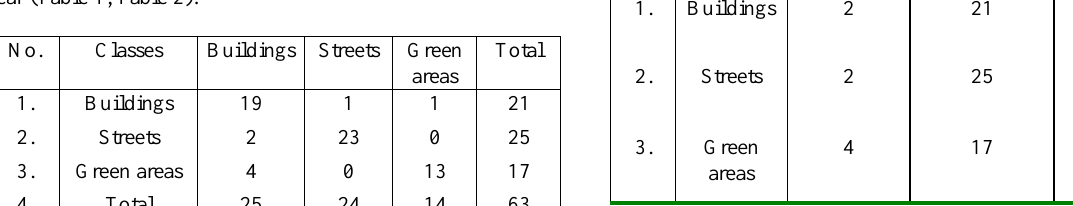
Table 5 . Commission error for the image from 2021